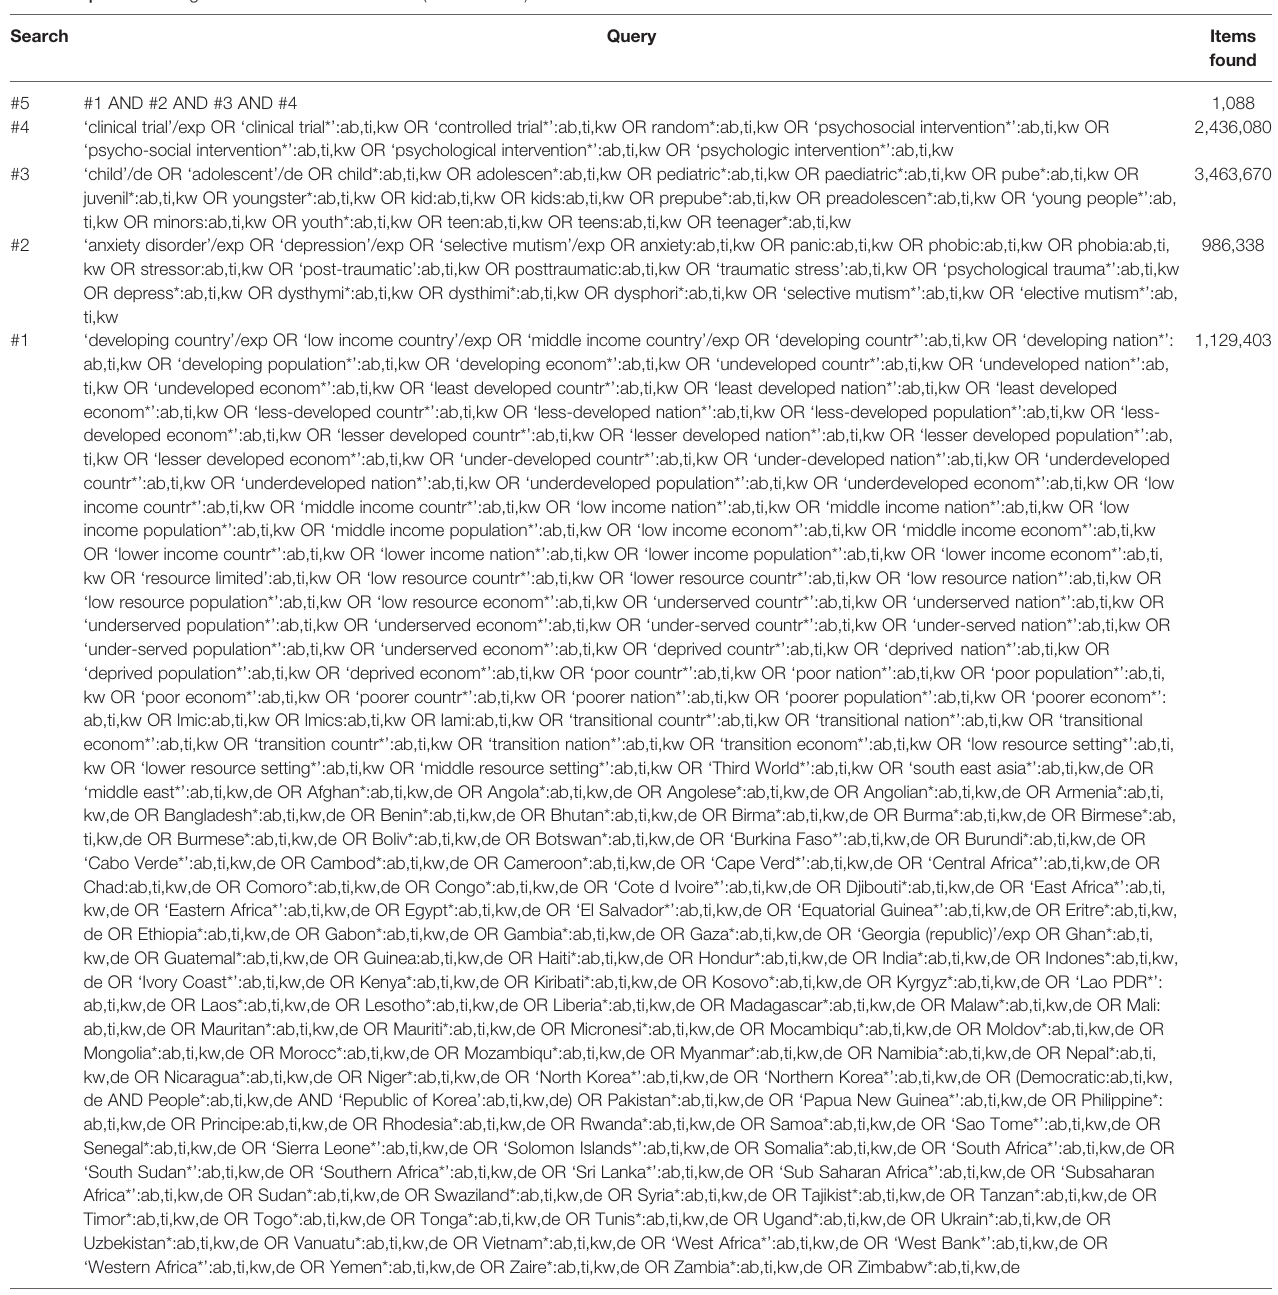
algorithm to guide the fi nal evaluation into one of the three categories. Questions within the paradigms differ slightly between the assessment for individual randomized trials and cluster randomized trials. Finally, an overall rating of the study was made based on the aforementioned ratings of the fi ve paradigms.